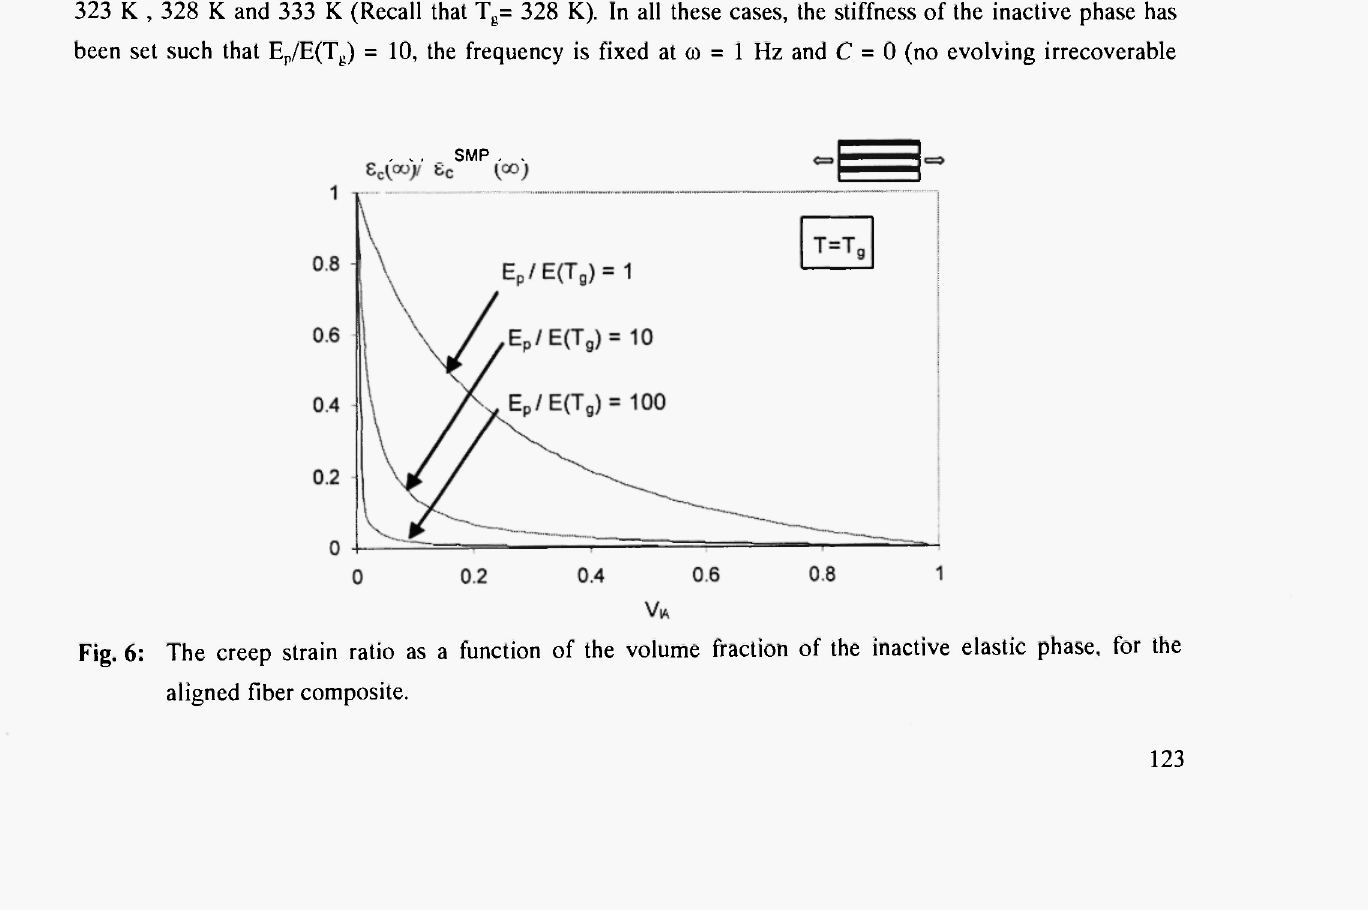
Fig. 6: The creep strain ratio as a function of the volume fraction of the inactive elastic phase, for the aligned fiber